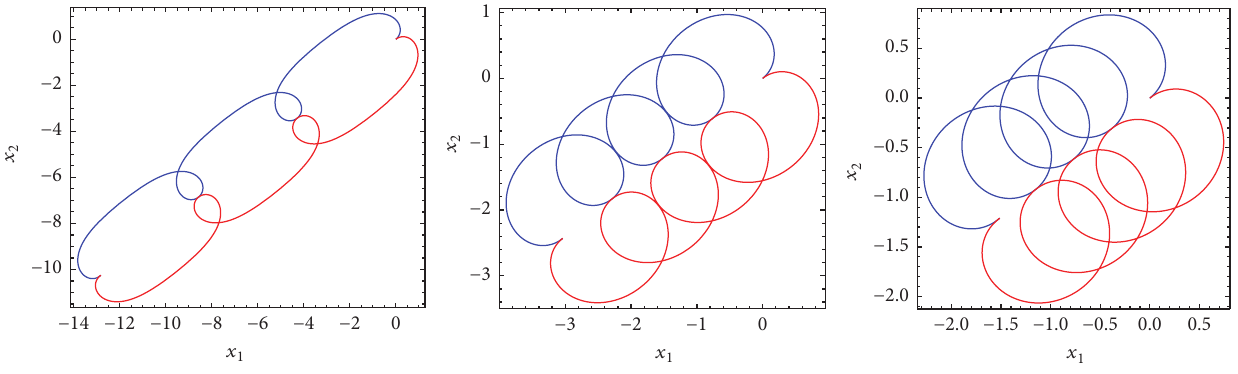
Figure 10: The trajectory of the center of the ball ( (ℎ,𝑐) ∈ Σ 𝑝 1 , 𝑘 = 5 , 𝑙 = 4 , 𝑥 0 1 = 𝑥 0 2 = 0